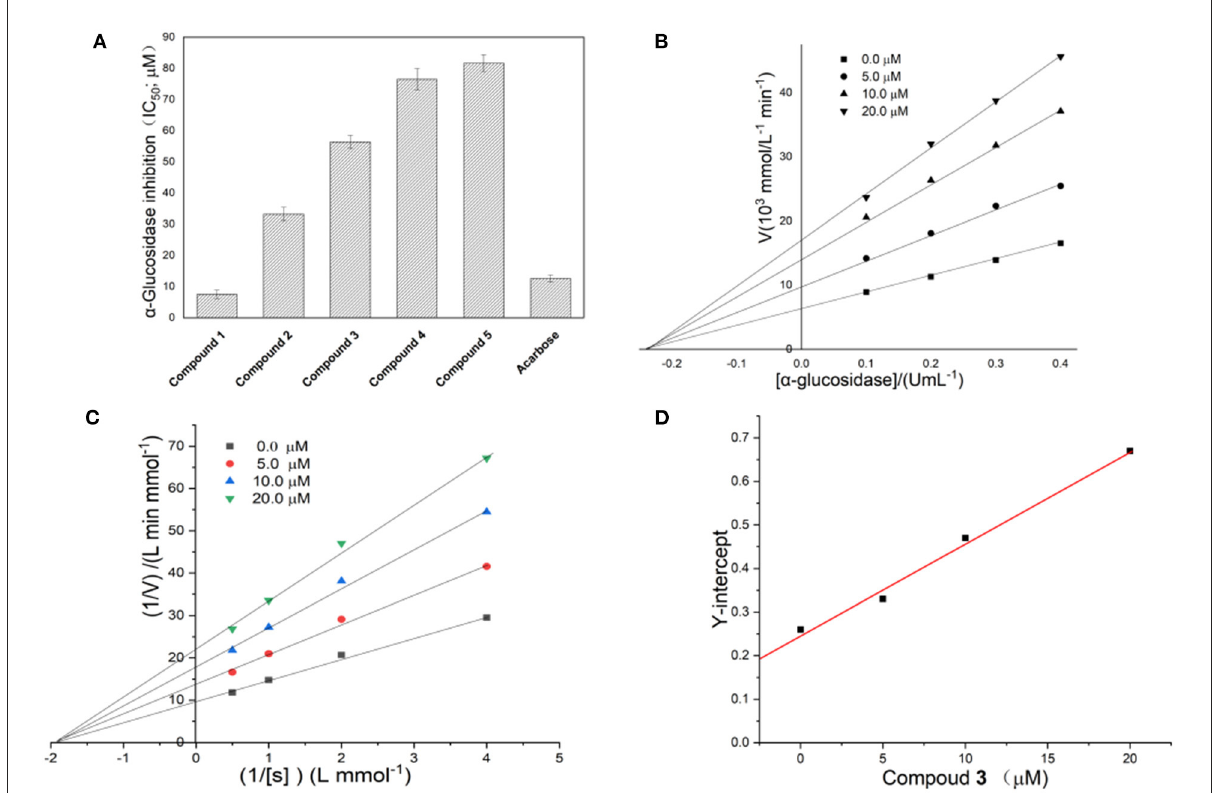
FIGURE4 (A) Inhibitory activity of compounds 1 – 5 on α -glucosidase; (B,C) Linewever-Burk plots of α -glucosidase inhibition. (D) Secondary replot of the Y-intercept vs. the concentration of compound 1